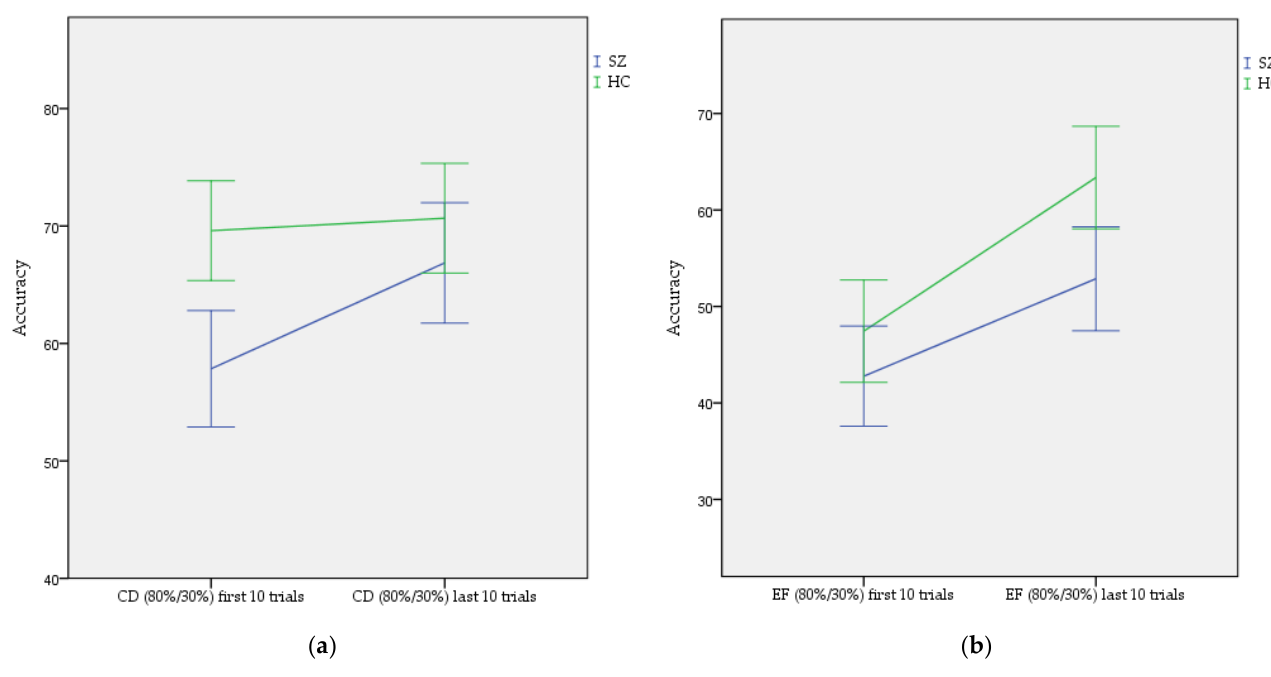
Figure 3. Comparison of performance during the training phase of IPST among schizophrenia (SZ) patients and healthy control (HC) participants: ( a ) first and last 10 trials of uninstructed CD (80%/30%) condition; ( b ) first and last 10 trials of instructed EF (80%/30%) condition. Green color refers to HC participants and blue color refers to the patients with SZ.